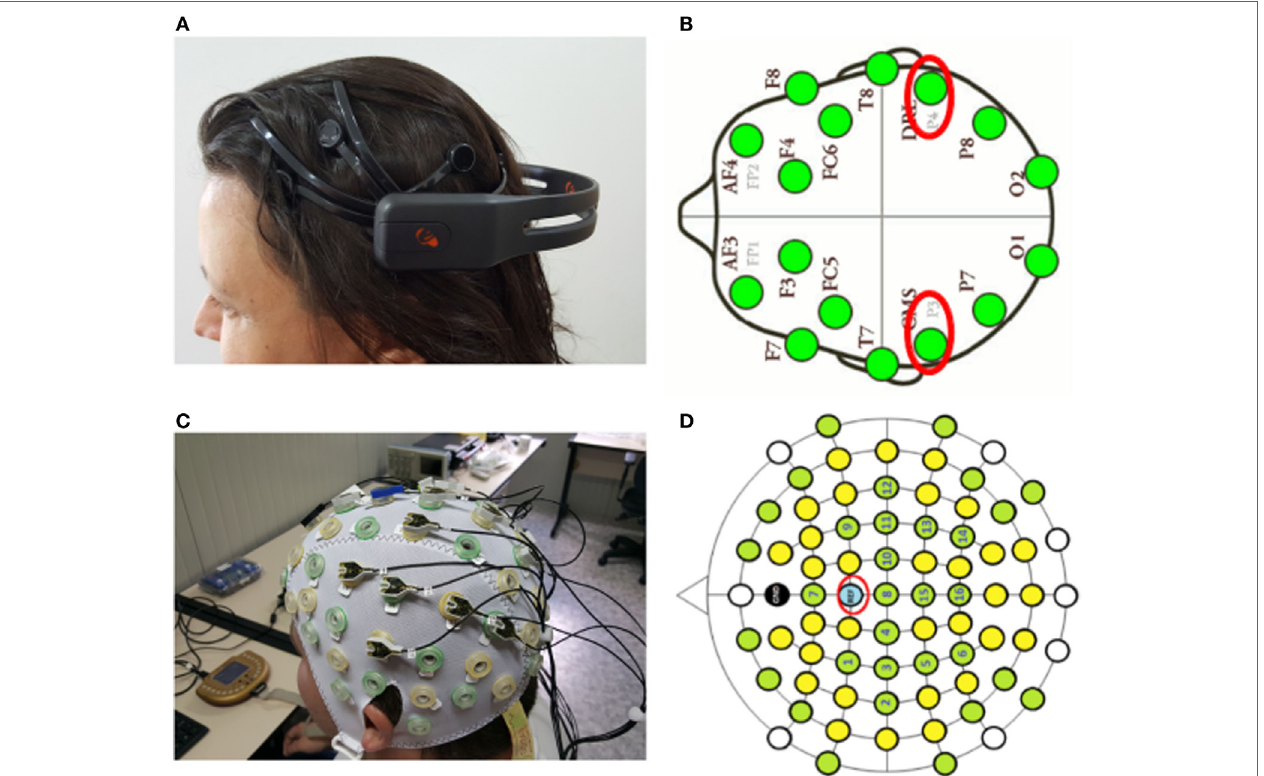
FigUre 3 | The two brain–machine interface headsets evaluated for use with the soft Orthotic Physiotherapy hand interactive aid system were: (a) the emotiv epoc + headset and (c) the acticaP . Insets (B,D) show the number of electrodes in each system, and circled in red are the reference